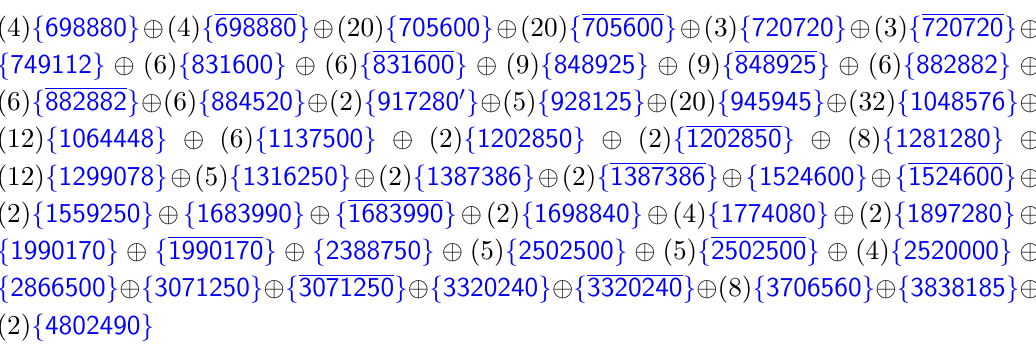
Figure 7 . Adinkra diagram for 10D, N = 2A at low